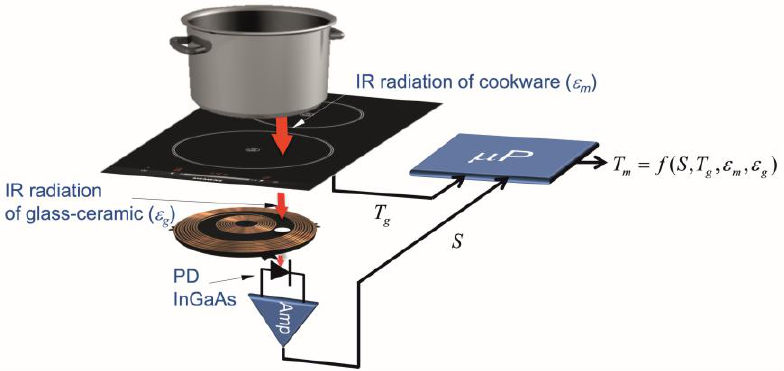
Figure 1. Cookware temperature measurement system based on an IR thermometry system which includes IR photodiode (PD), electronic amplifier and algorithm to estimate the